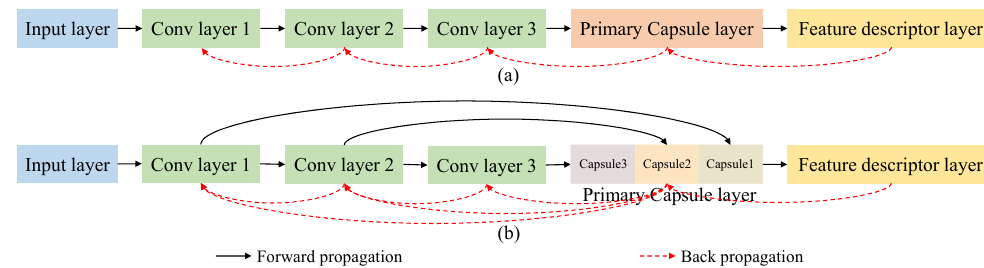
Figure 7. Illustration of the backpropagation pathway. ( a ) Traditional connected pathway. ( b ) The proposed densely connected pathway.